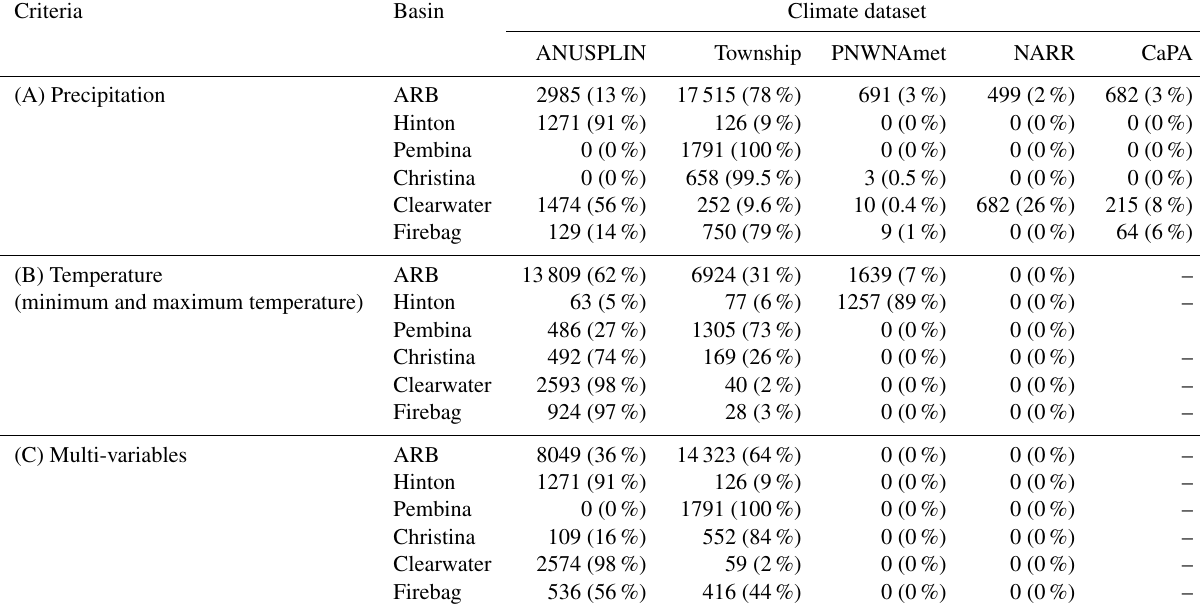
Table 5. First-ranked number of grid cells in the five sub-basins and the whole Athabasca River basin (ARB) and their percentages for each climate dataset, considering the performance measures of the cases with individual (Case A and B) and multi-variables (Case C, i.e., precipitation and temperature in this study). Total number of grid cells is 22372 at 1 / 32 ◦